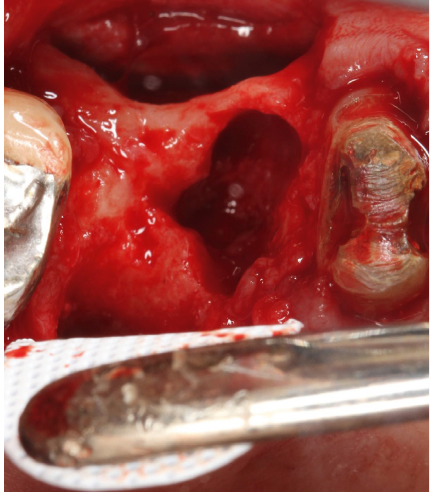
Figure 4: Intraoral picture of the extraction site of #3. The buccal plate showed horizontal deficiency. The nonresorbable high density PTFE membrane was placed on the lingual aspect of #3.